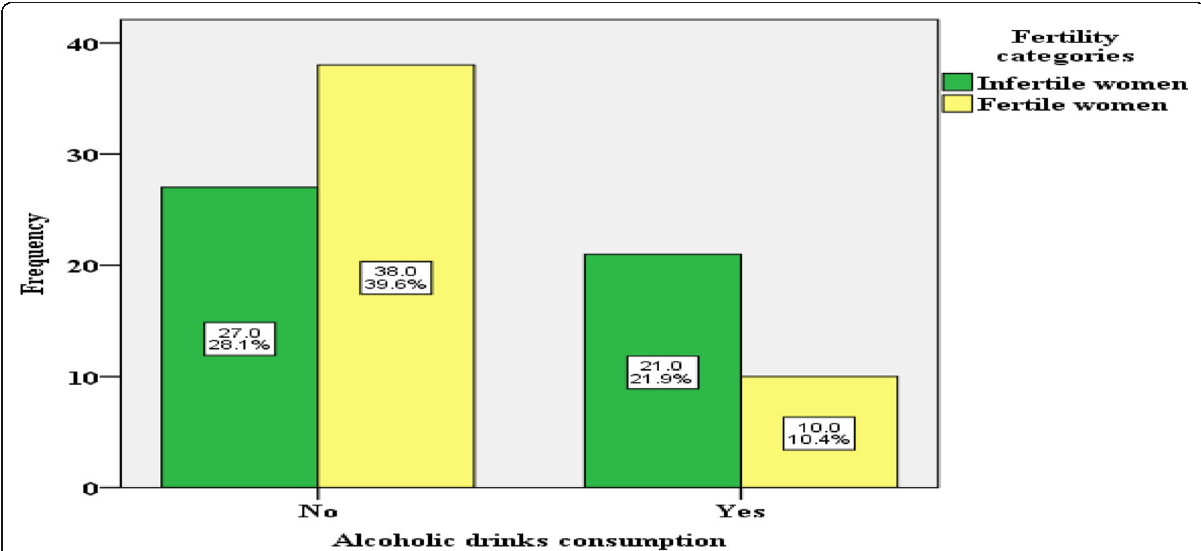
Fig. 1 Bar chart showing alcohol consumption habits of fertile and infertile women attending MNH, Dar es Salaam,